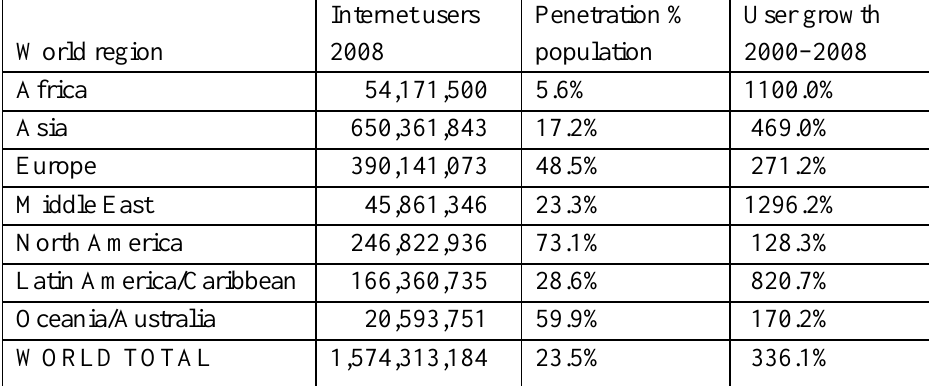
Internet users Penetration % User growth 2008 population 2000–2008